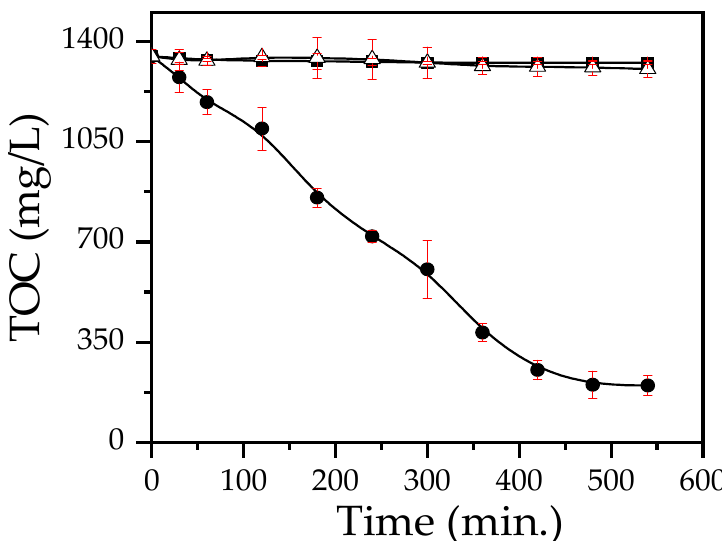
Figure 3. Mineralization by TOC decay of winery wastewater during electrolysis without the addi- tion of electrolyte support at 25 °C and pH 4.28 applying 30 mA/cm 2 . ( ■ ) MMO-Cl 2 , ( ∆ ) MMO-O 2 , ( ● ) BDD. Samples tested: 11. BDD. Samples tested: